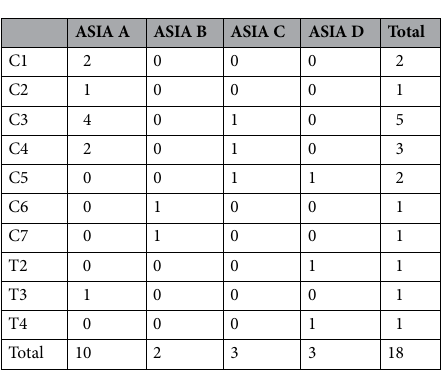
Table 4. Location and severity of traumatic spinal cord injury (TSCI). Data are expressed in absolute numbers. ASIA American Spinal Injury